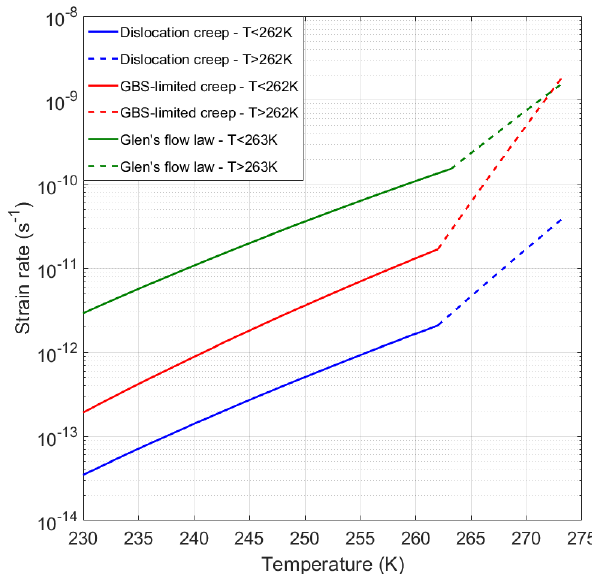
Figure 4. Log strain rate versus temperature for Glen’s flow law and the two mechanisms (dislocation creep and GBS-limited creep) that form the members of the modified composite flow law, using the flow law parameters from Table 3. A stress of 0.07MPa and a mean grain diameter of 5mm were used to calculate the strain